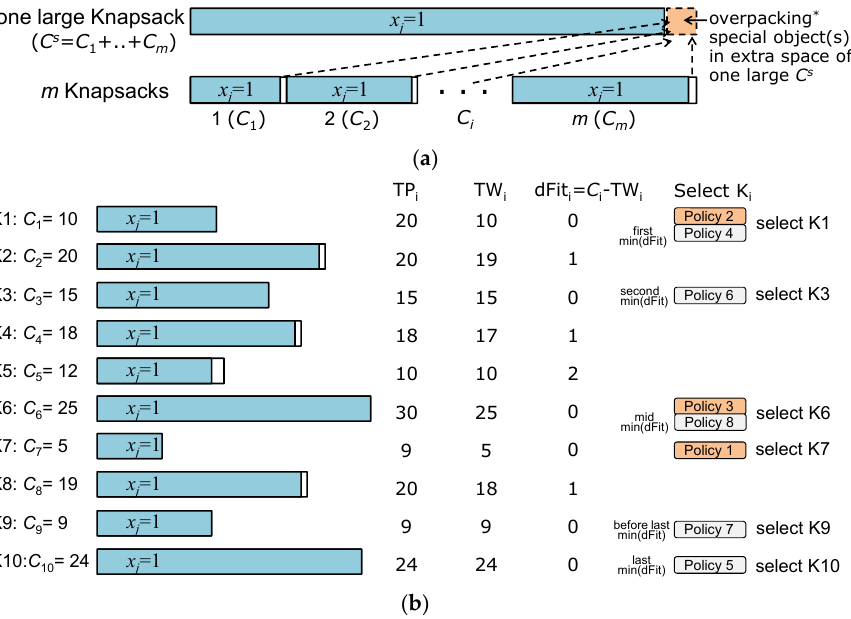
Figure 20. ( a ) Overpacking (in the extra space of one knapsack with large total-capacity C s ) in critical datasets and ( b ) an example of eight effective policies (to handle the critical decisions).